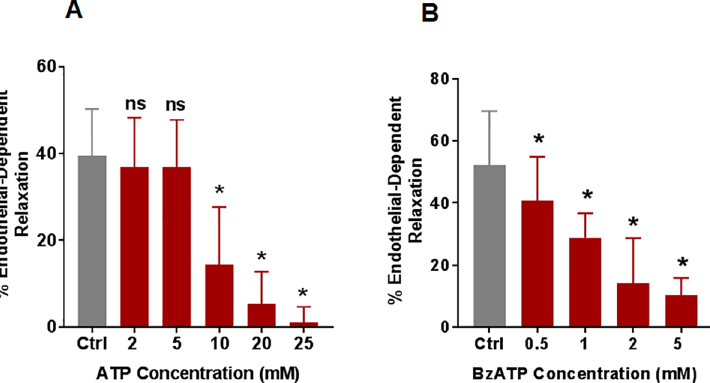
Fig 2. eATP stimulation of RA decreasedendothelial function. A. RA rings were treated with eATP (2,5,10, 20 and 25 mM) for 1hour, suspendedin the muscle bath, pre-contracted with phenylephrine (0.5 μ M) and treated with carbachol (0.5 μ M), n = 5–10, * p < 0.05 comparedto control, ns = not significantcompared to control. B . RA rings were suspendedin a muscle bath and either untreated or treated with 2’(3’)-O- (Benzoylbenzoyl) adenosine 5’–triphosphate (BzATP, 0.5, 1, 2, and 5 mM) for 1 hr, and the vessels were pre- contracted with phenylephrine (0.5 μ M) and treated with carbachol (0.5 μ M). n = 4–7 segments from different rats, * p < 0.05compared to control